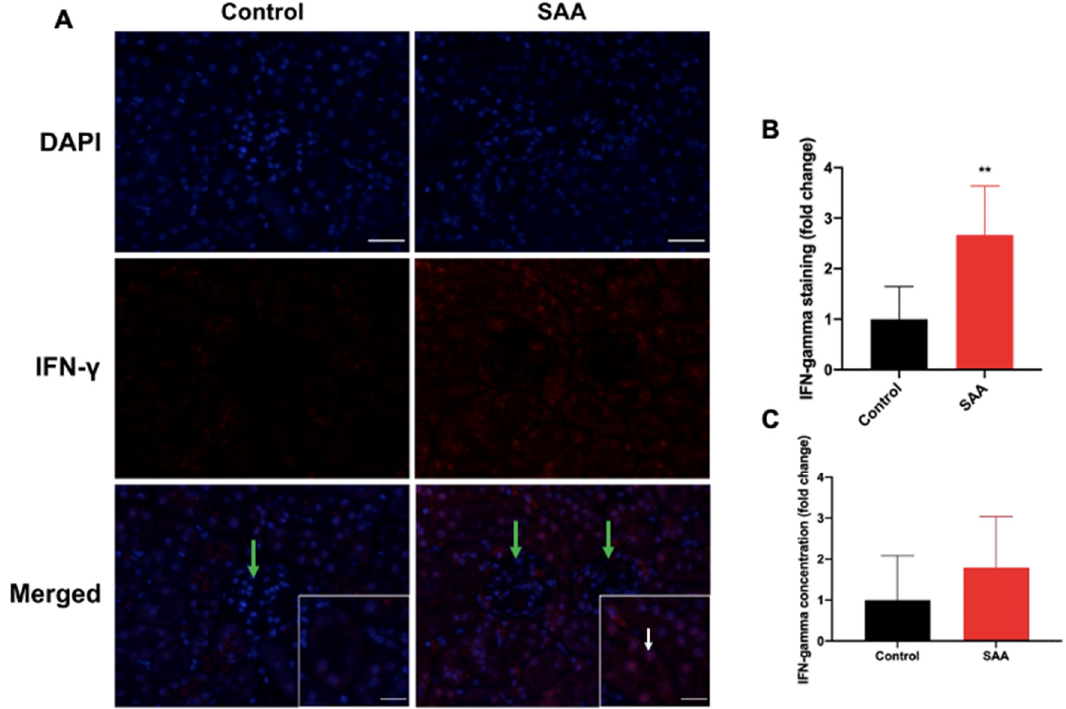
Figure 7. SAA administration stimulates IFN- γ expression in the renal cortical tissue. ( A ) Male ApoE − / − mice were randomly allocated to vehicle control (administered 100 µL PBS every 3 days for 2 weeks) and the SAA group (administered 12 µg SAA protein every 3 days for 2 weeks). Kidney tissue was harvested 4 weeks after cessation of treatment and fixed in situ before embedding and sectioning (5 µm). Renal sections were dewaxed then rehydrated before undergoing heat-induced antigen retrieval. IFN- γ localisation was assessed using immunofluorescence microscopy. Slides were visualised at 40× magnification (scale bar = 20 µm); images are representative of at least 4 fields of view for each sample. Nuclei were stained with DAPI (blue) and IFN- γ with an appropriate Opal fluorophore (red). White arrow indicates IFN- γ staining primarily localised to renal epithelial cells and minimally in the glomerular endothelium (glomeruli indicated by green arrow). Insets show higher magnification (scale bar = 10 µm) images of renal tubular epithelial cells with IFN- γ staining largely colocalised to nuclei with some residual cytoplasmic staining. Representative images show cortical fields from n = 5 (control), n = 6 (SAA). ( B ) Immunostaining was quantified using a mean staining intensity for each field of view and averaged for each sample. Data shown as relative mean ± SD. ** Different to the control group; p < 0.001. ( C ) An ELISA kit was utilised to quantify renal IFN- γ as described in the methods section. Results shown as relative mean ± SD.